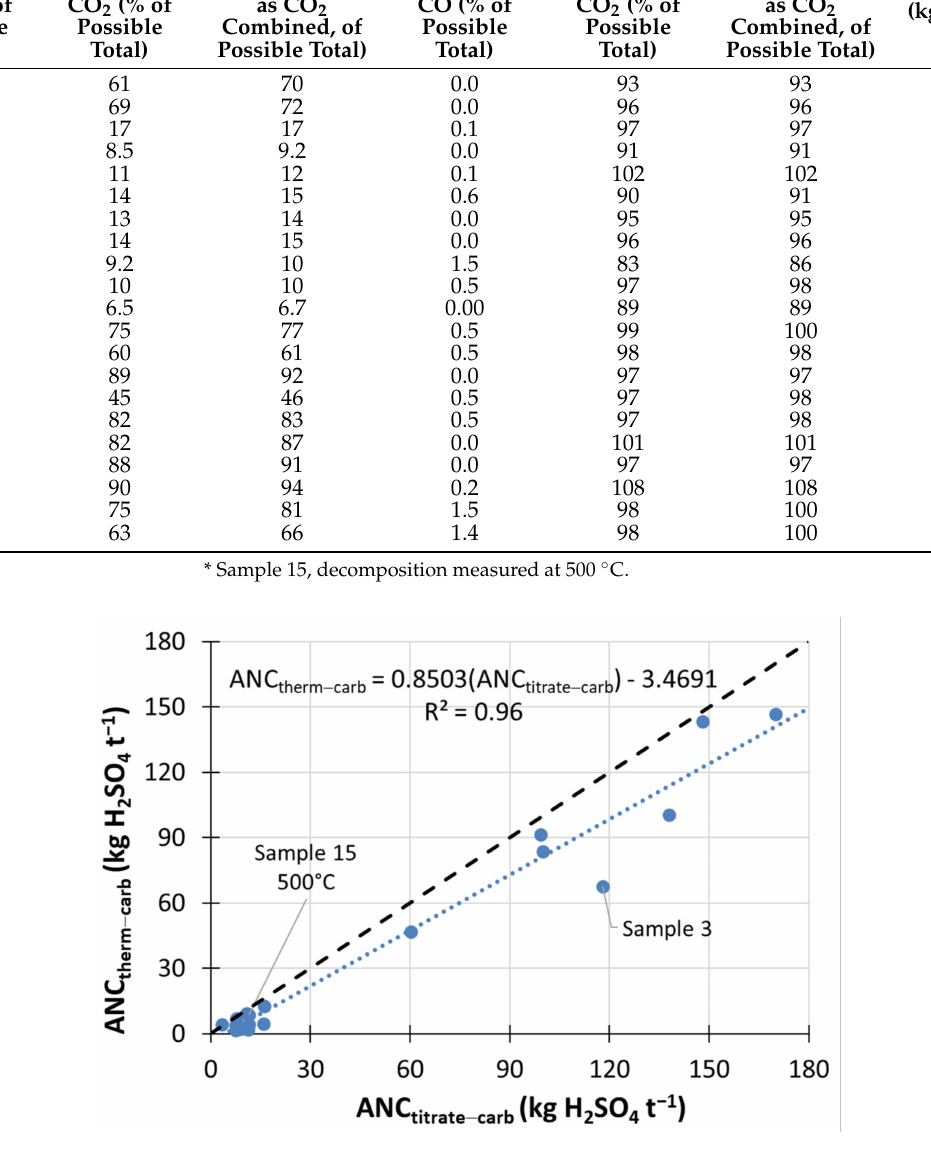
Figure 5. Correlation of ANC therm-carb (using decomposition data at 450 ◦ C except for sample 15 for which decomposition data at 500 ◦ C was used) with the ANC titrate-carb values. The dark dotted line indicates the ratio of 1:1 (note that R 2 for this line = 0.86). For sample 3 the greater ANC titrate-carb than ANC therm-carb value is likely due to the partial inclusion of neutralisation from Mg-clay in the ANC titrate-carb